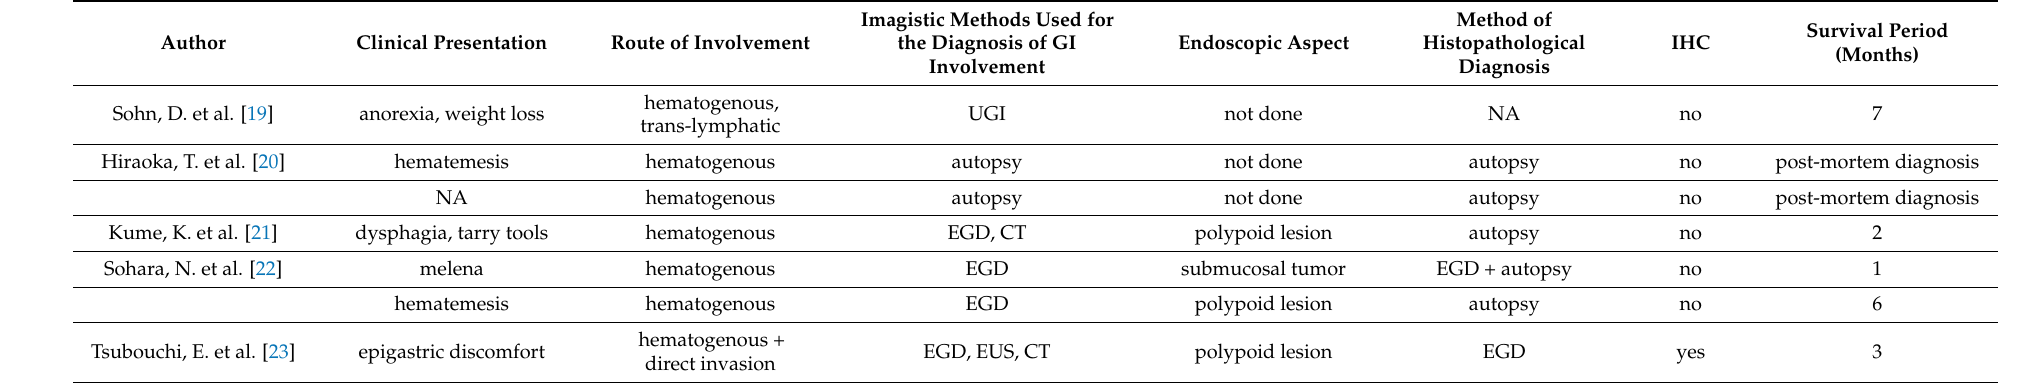
Table 2. Literature review of cases with gastrointestinal involvement from hepatocellular carcinoma—features of GI